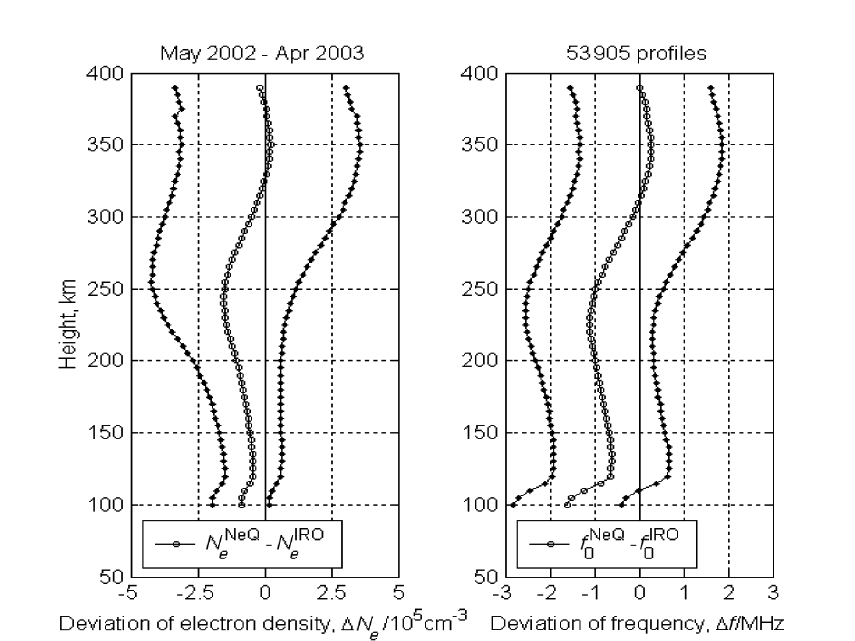
Fig. 7.13. Statistical comparison of IRO and NeQuick derived EDPs. Left panel: electron density N e ; right pan- el: plasma frequency f p